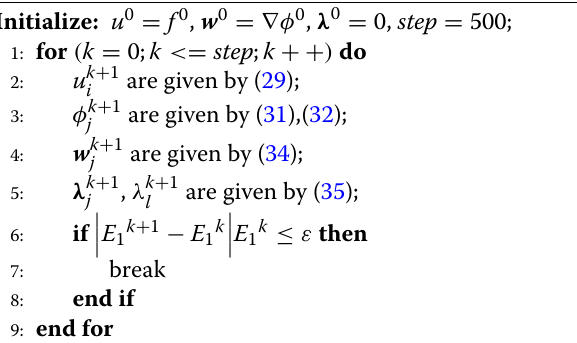
Algorithm 1 ADMM of modified Vese-Chan model for gray